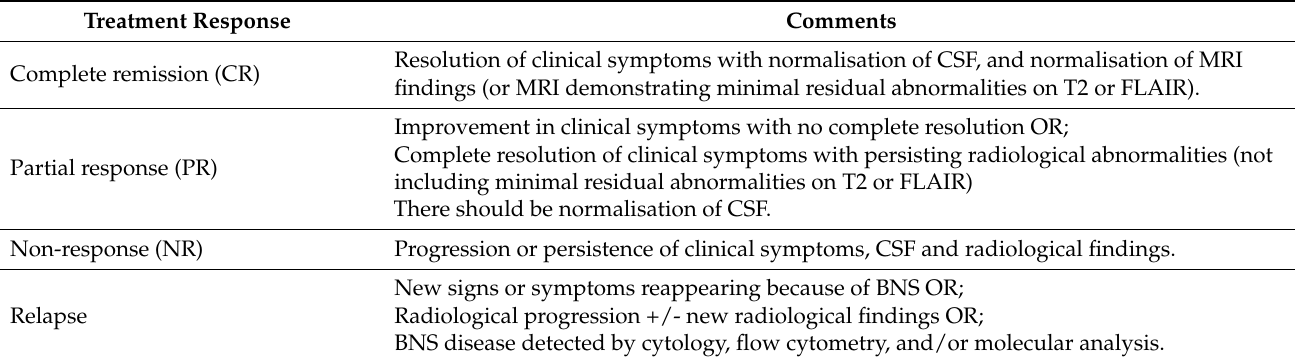
Table 5. Treatment response criteria for Bing–Neel